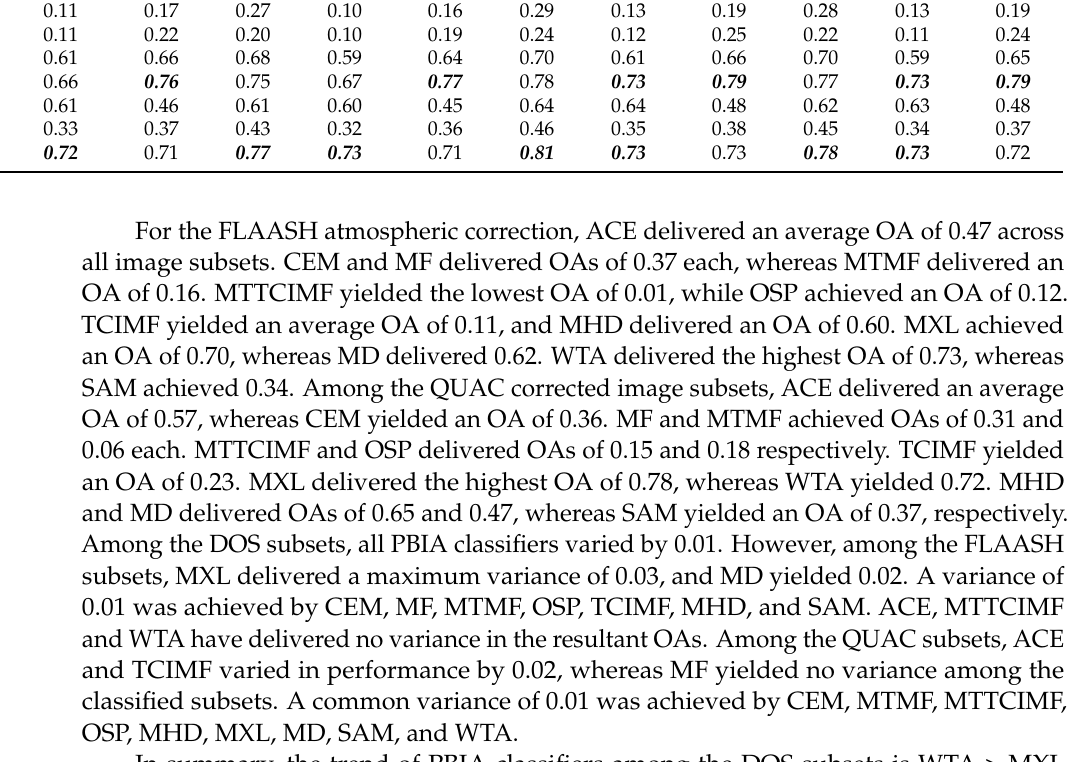
as a comparative measure. Table 8 displays the ER for all PBIA classifiers across each image subset based on methods of